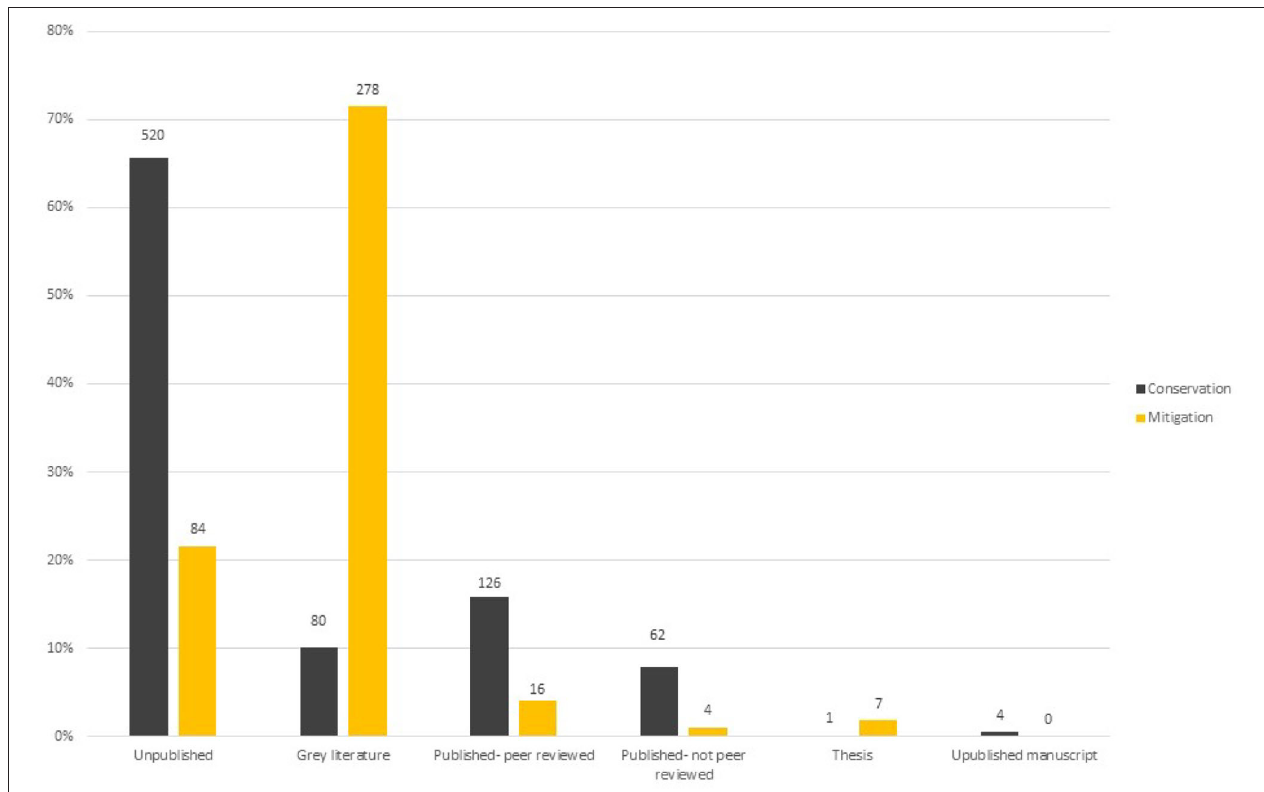
FIGURE 2 | Breakdown by self-reported publishing medium of mitigation and conservation translocations submitted to the Australasian Translocation Database. Columns represent percentage of total record type (conservation or mitigation) and numbers are total number of records. Raw data (as submitted) was used and varies slightly from data presented by Silcock et al. (2019) which referred mostly to “completed”